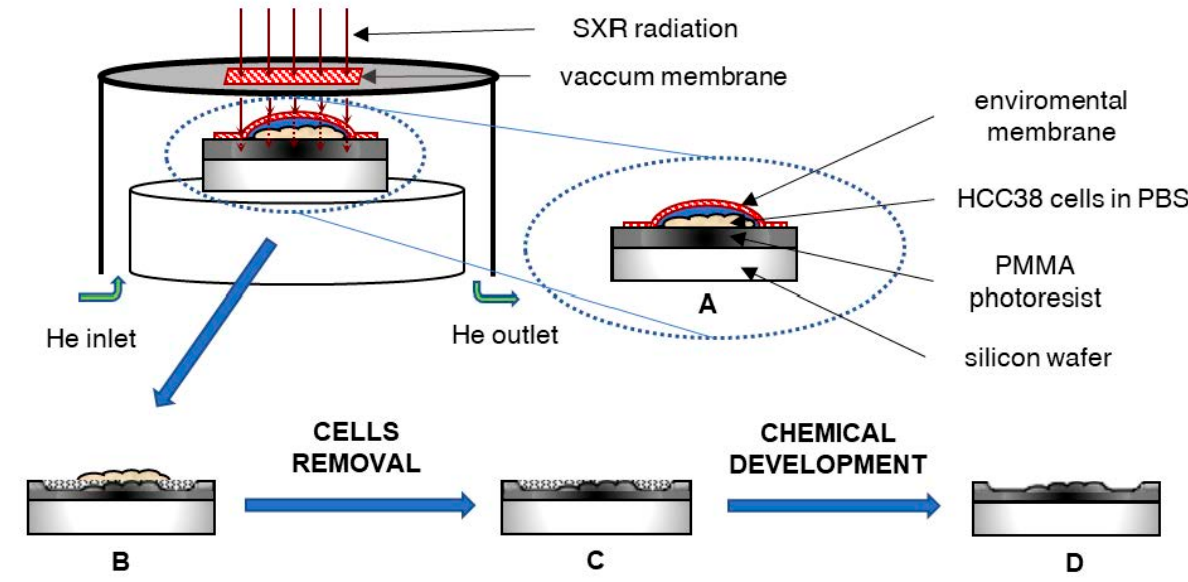
Figure 5. The scheme of the X-ray contact microscopy system: ( A ) The HCC38 cells attached to PMMA photoresist in PBS solution and covered with a membrane (protection against drying) were exposed to X-ray radiation. ( B ) The photoresist was degraded to an extent depending on the absorption of radiation by the cells. ( C ) Then, the cells were removed from the photoresist surface and ( D ) the photoresist was chemically developed to remove degraded polymer.